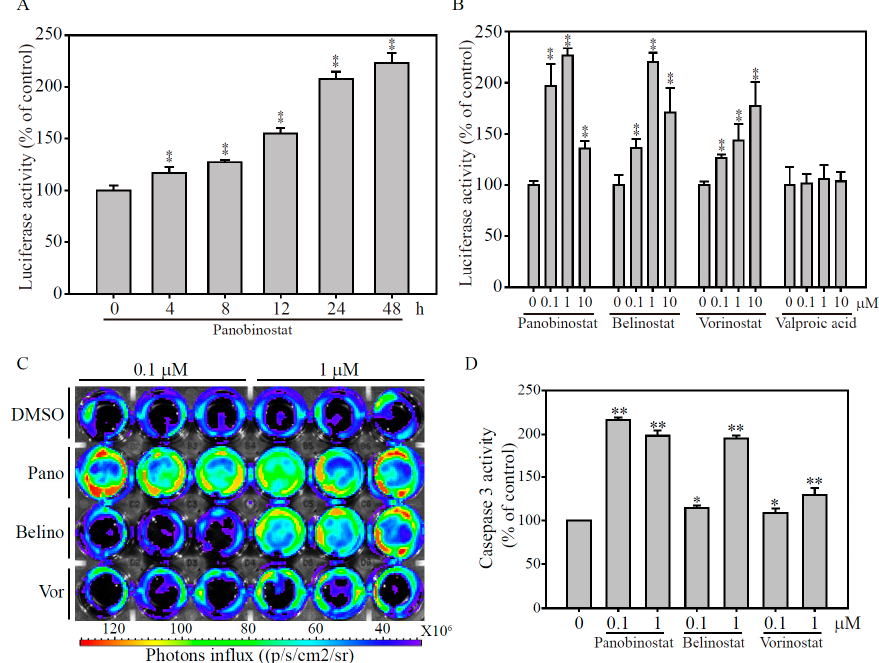
Figure 4. HDACi-induced apoptosis through NIADS assay. ( A ) A time-dependent manner (from 4 to 48 h) of Panobinostat treatment on NIADS-MDA-MB-231 cells. The cells received 1 μ M of Panobinostat and their luciferase activity was measured. ( B ) Dose-dependent manner (from 0.1 to 10 μ M) of HDACi treatments on NIADS-MDA-MB-231 cells. The cells received HDACi for 24 h tand